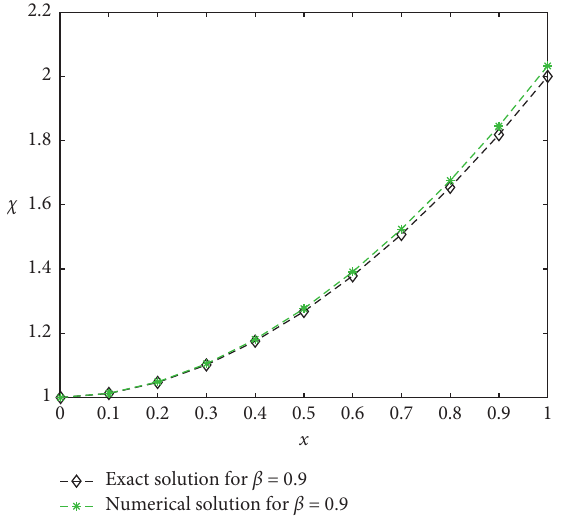
Figure 7: The numerical and exact solutions for fractional order β � 0 . 9.